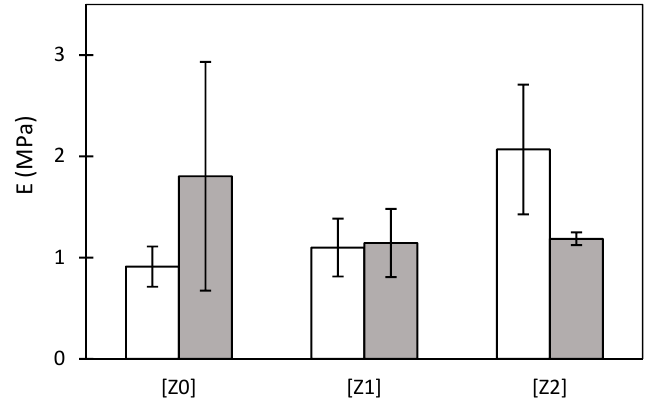
Figure 4. Young’s moduli of the starch aerogels monoliths obtained from different zein porogen contents. Mechanical properties of aerogels were evaluated before (white bars) and after (gray) supercritical sterilization treatment. Results showed no statistical differences (2-way ANOVA), [F 2,10d.f. = 1.37; p < 0.05], [F 2,10d.f. = 4.7 × 10 − 3 ; p < 0.05], and [F 2,10d.f. = 3.27; p < 0.05] for factors “zein content” and “sterilization treatment”, and its interaction,